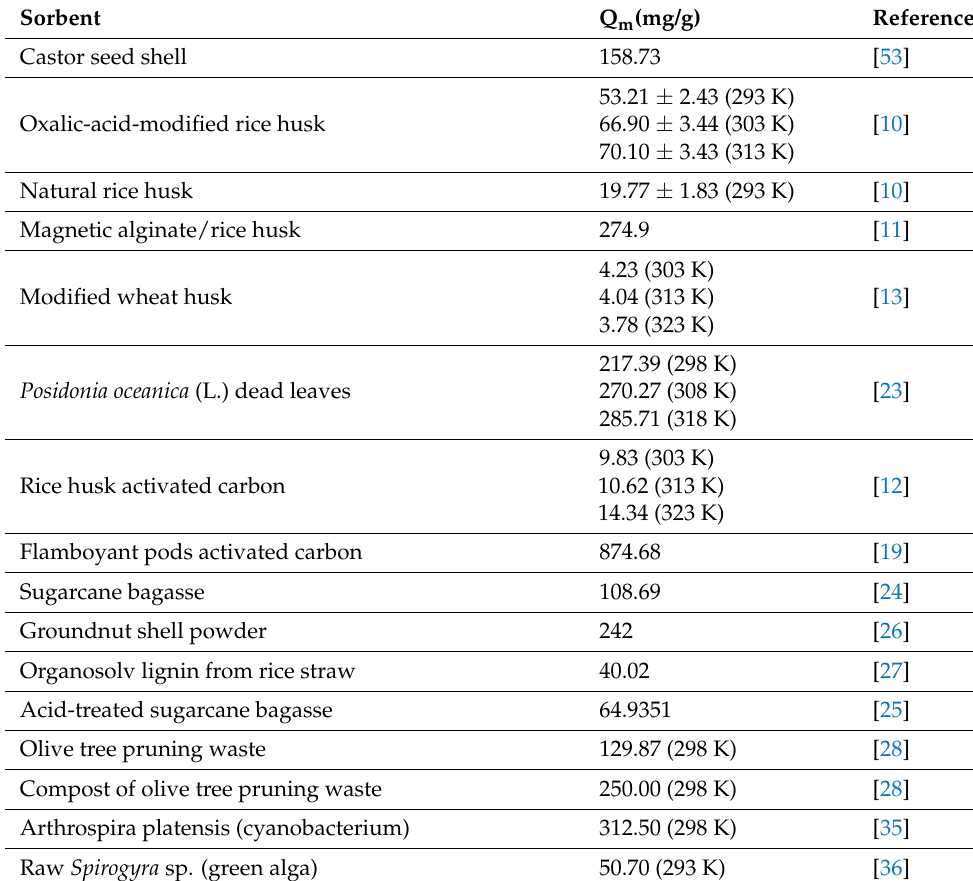
Table 1. Langmuir sorption ability (Q m in mg/g ) of various sorbents of